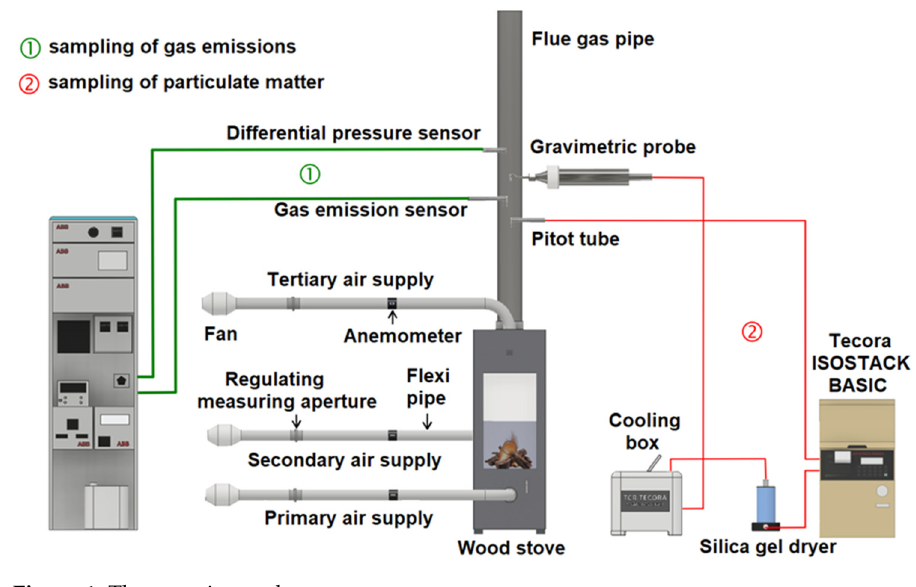
Figure 1. The experimental setup.